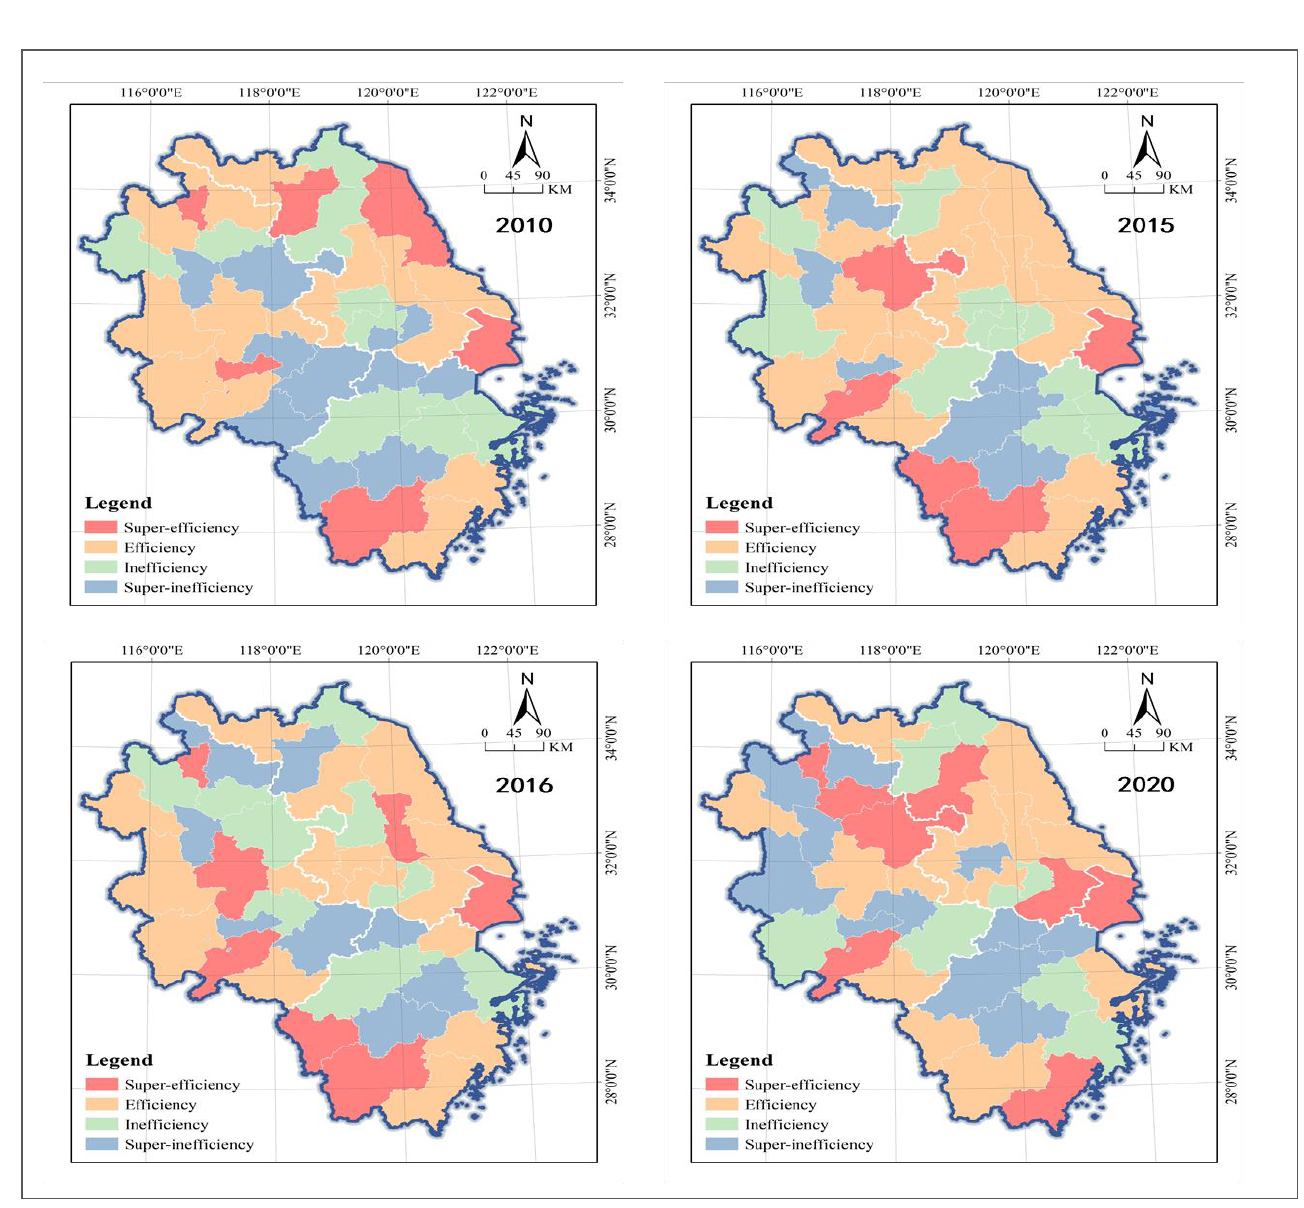
Figure 9. Analysis on the pure technical efficiency of real estate inventory in Yangtze River Delta.